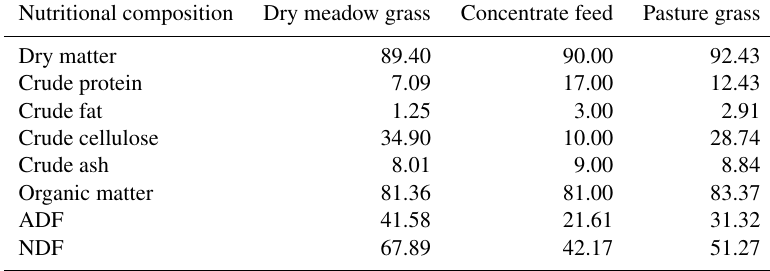
Table 1. Nutritional composition of feeds used in fattening systems and samples taken from pasture (%). Nutritional